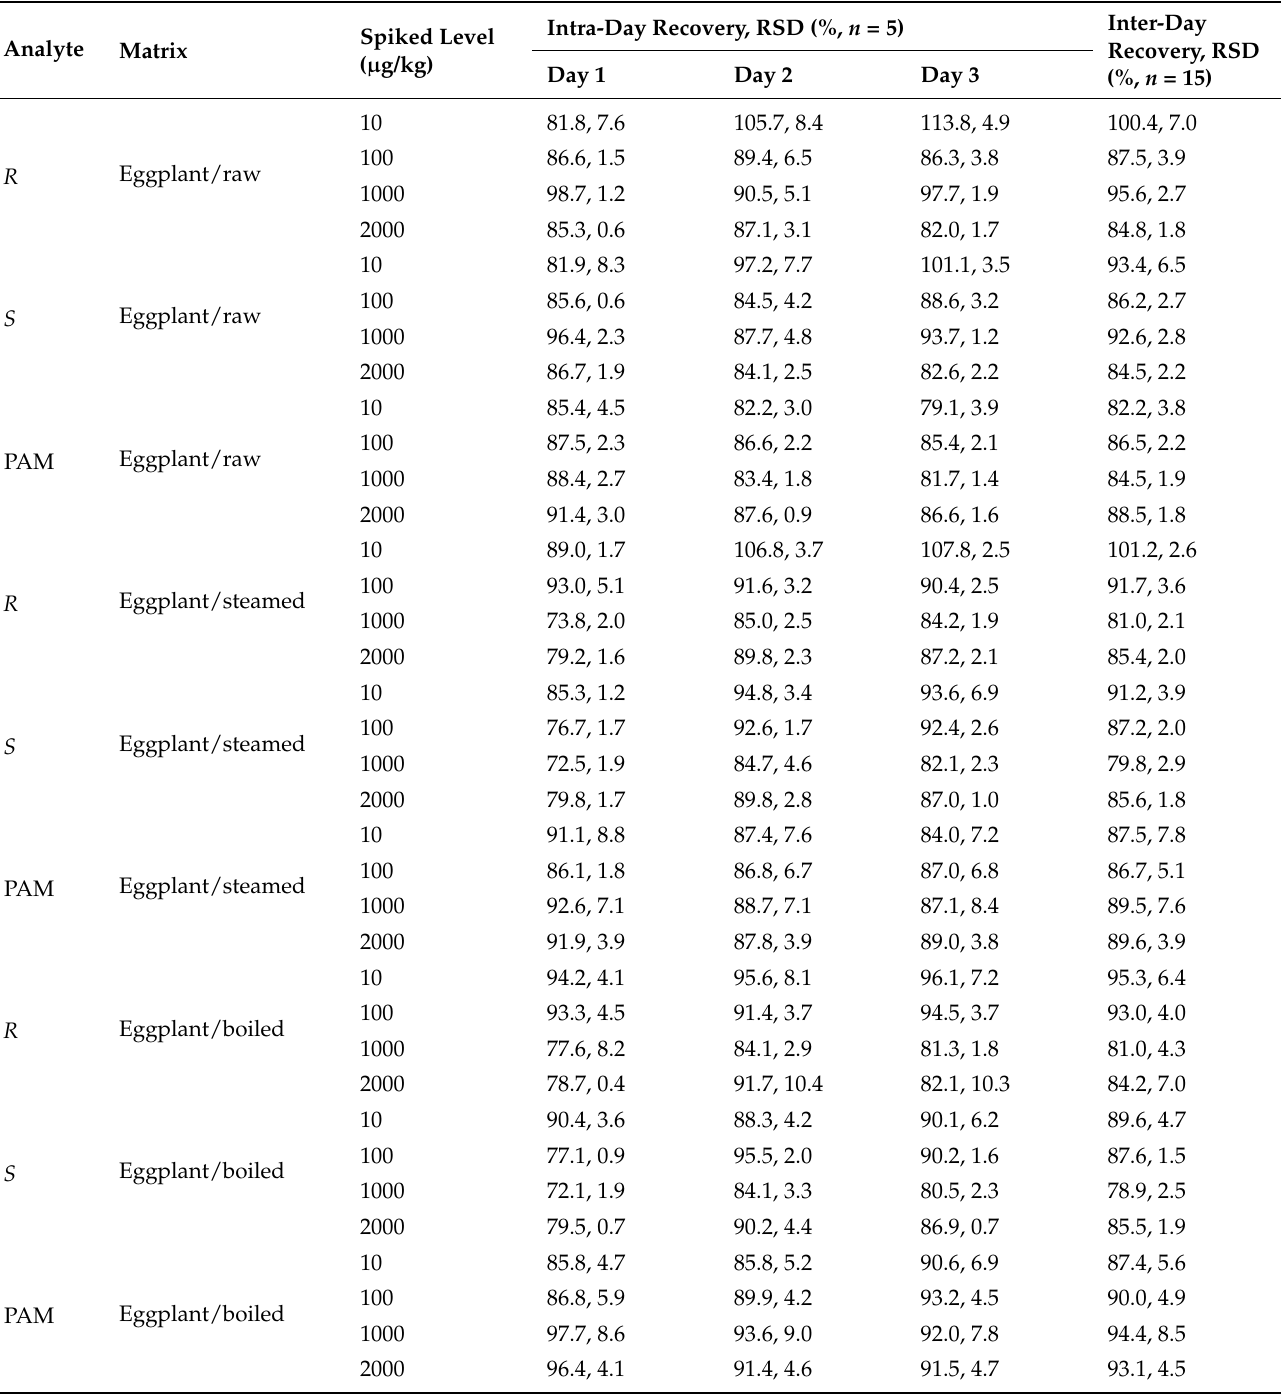
Table 2. Recoveries and relative standard deviations (RSDs) of penthiopyrad stereoisomers and PAM in